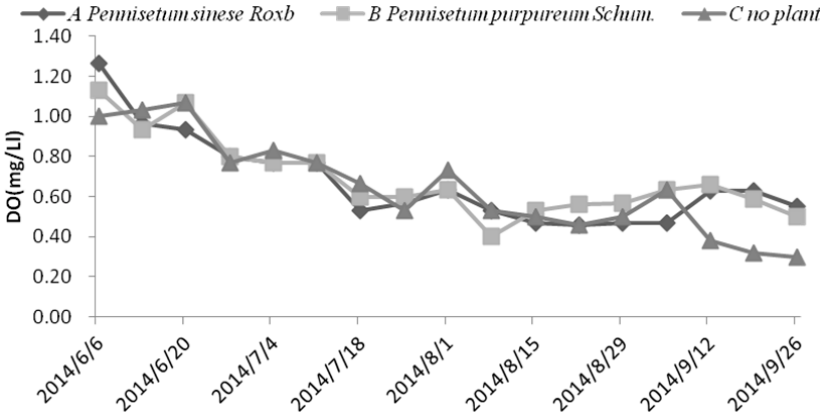
Figure 3. DO of the effluent in three systems.